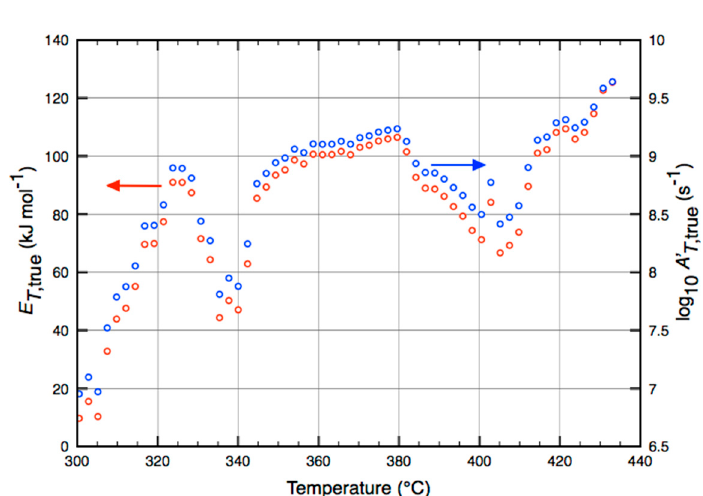
(cid:1827) (cid:3021),(cid:2930)(cid:2928)(cid:2931)(cid:2915)(cid:4593) (blue circles) A (cid:48) (blue circles) T ,true 10 10